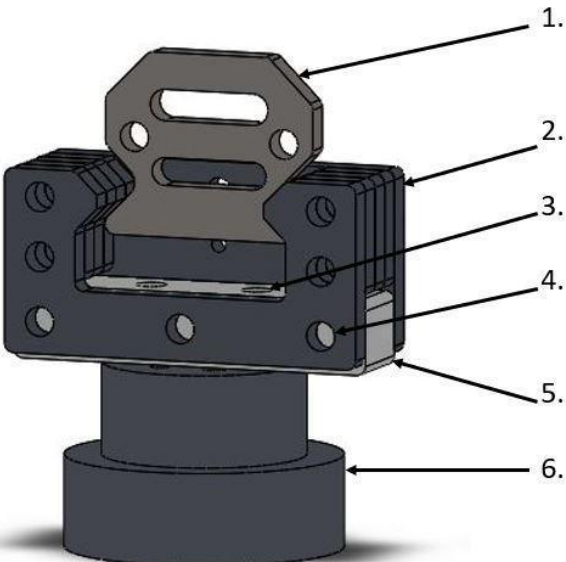
Figure 2. Jaw holders for SMT with electrical insulation: 1. Jaw element, 2. steel holder for the jaw, 3. vertical hole in the insulator for fixing it to the base, 4. horizontal hole for mounting an insulator with a steel holder for jaws, 5. insulator with polyamide, 6. base connecting the insulator with the rest of the